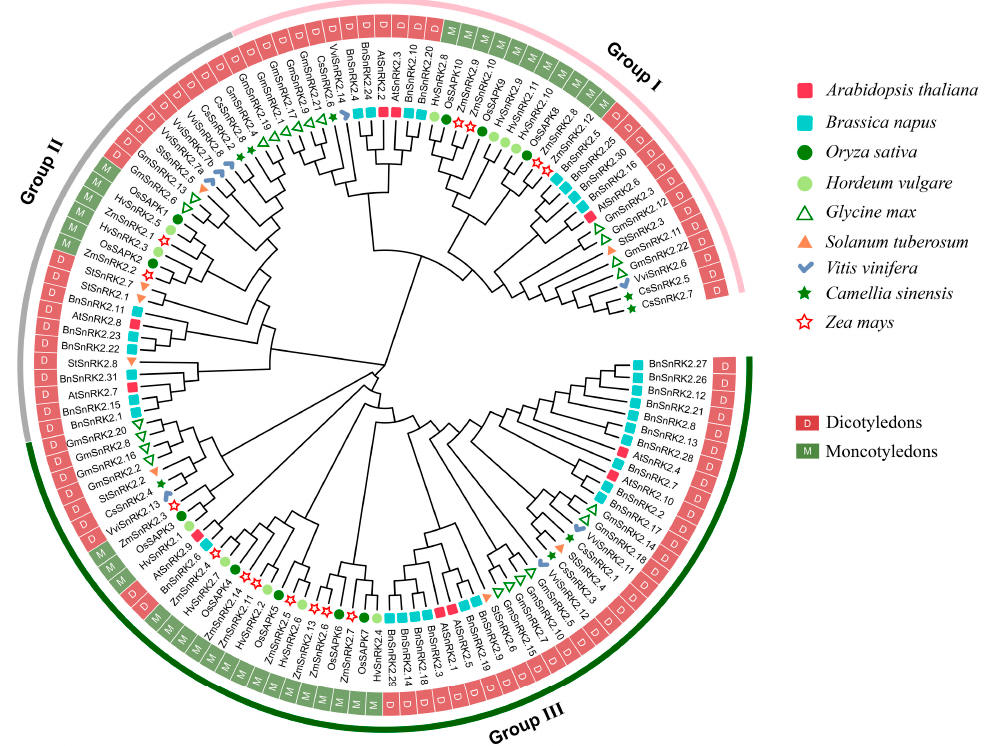
Figure 2. Unrooted phylogenetic tree representing the relationships among 8 StSnRK2 proteins from Solanum tuberosum and 114 SnRK2 proteins from three monocots and five dicots. The phylogenetic trees were constructed using the neighbor-joining (NJ) method in MEGA7.0, and the default parameter value was set to